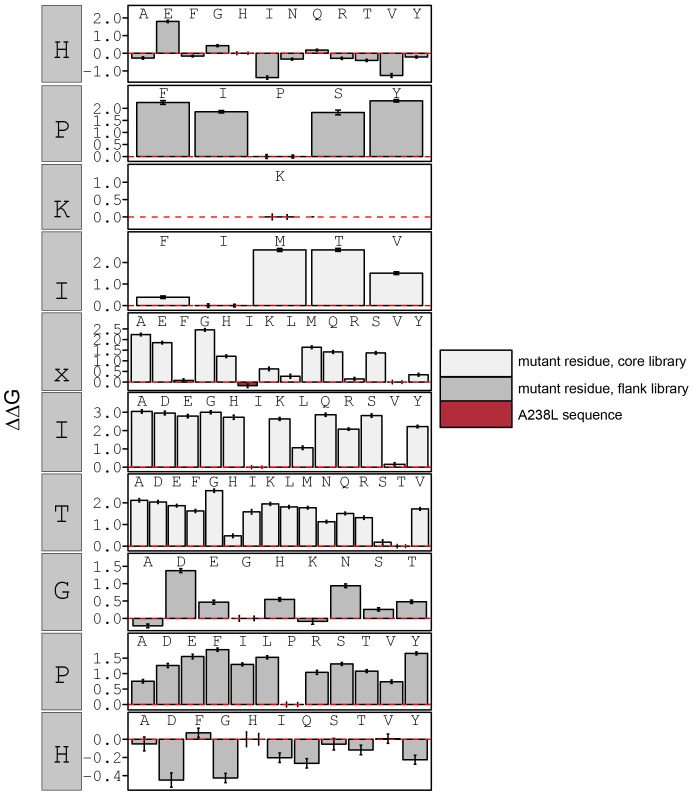
ΔΔG calculated in reference to PKIVIT WT.Peptide sequence AGPHPKIIITGPHEE (red) contains a PxIxIT motif similar to the A238L viral inhibitor.